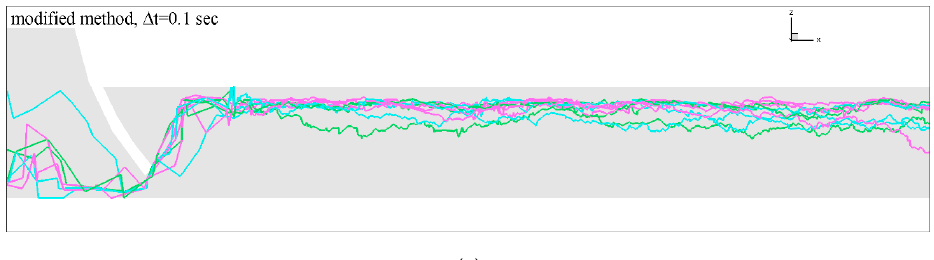
Figure 6. Pathway of fishes for the original and modified agent-based (AB) method. ( a ) Velocity vectors of fluid flow showing the generation of a big circulation zone behind the tainter gate. Colors indicate the magnitude of the velocities. The center and the end of the circulation zone are shown with arrows. ( b ) Fishes pathway of the original algorithm and ( c )–( e ) of the modified algorithm with ( c ) ∆𝑡 = 1.0 s , ( d ) ∆𝑡 = 0.5 s and ( e ) ∆𝑡 = 0.1 s . To facilitate the visual view of the fishes pathway only 10 of the simulated 100 fishes are shown here.